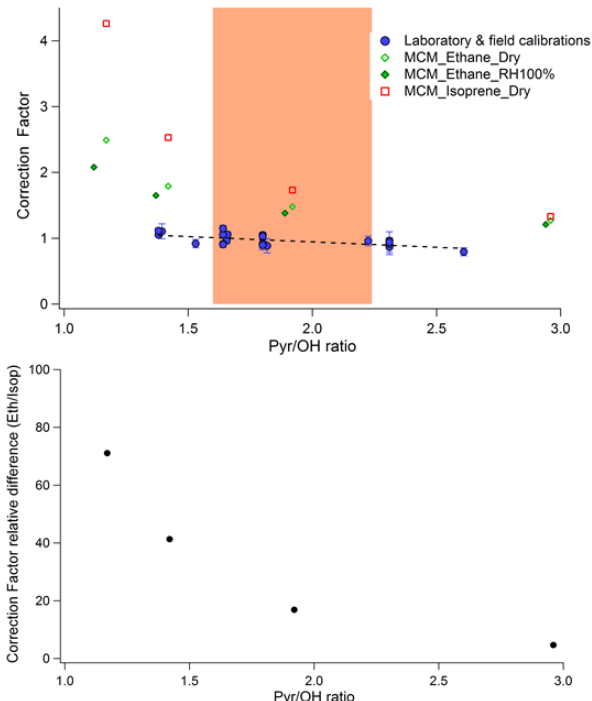
Figure 9. Comparison of model simulations to laboratory obser- vations for the artifact caused by not operating the instrument un- der pseudo-first-order conditions. Top panel: trends of the simu- lated and measured correction factors with the pyrrole-to-OH ra- tio. The measured correction factors (blues circles) are the same as in Fig. 7. The simulated correction factors stem from simula- tions conducted using MCM and constrained with ethane under dry conditions (green open diamonds) and wet conditions (green filled diamonds), or constrained with isoprene under dry conditions (red open squares). The colored area corresponds to the range of pyrrole- to-OH ratios observed during field measurements (1.6–2.2). Bot- tom panel: trend of the relative difference between correction fac- tors simulated under dry conditions for ethane and isoprene as a function of the pyrrole-to-OH ratio. Relative difference calculated as 100 × (F isoprene -F ethane ) /F ethane